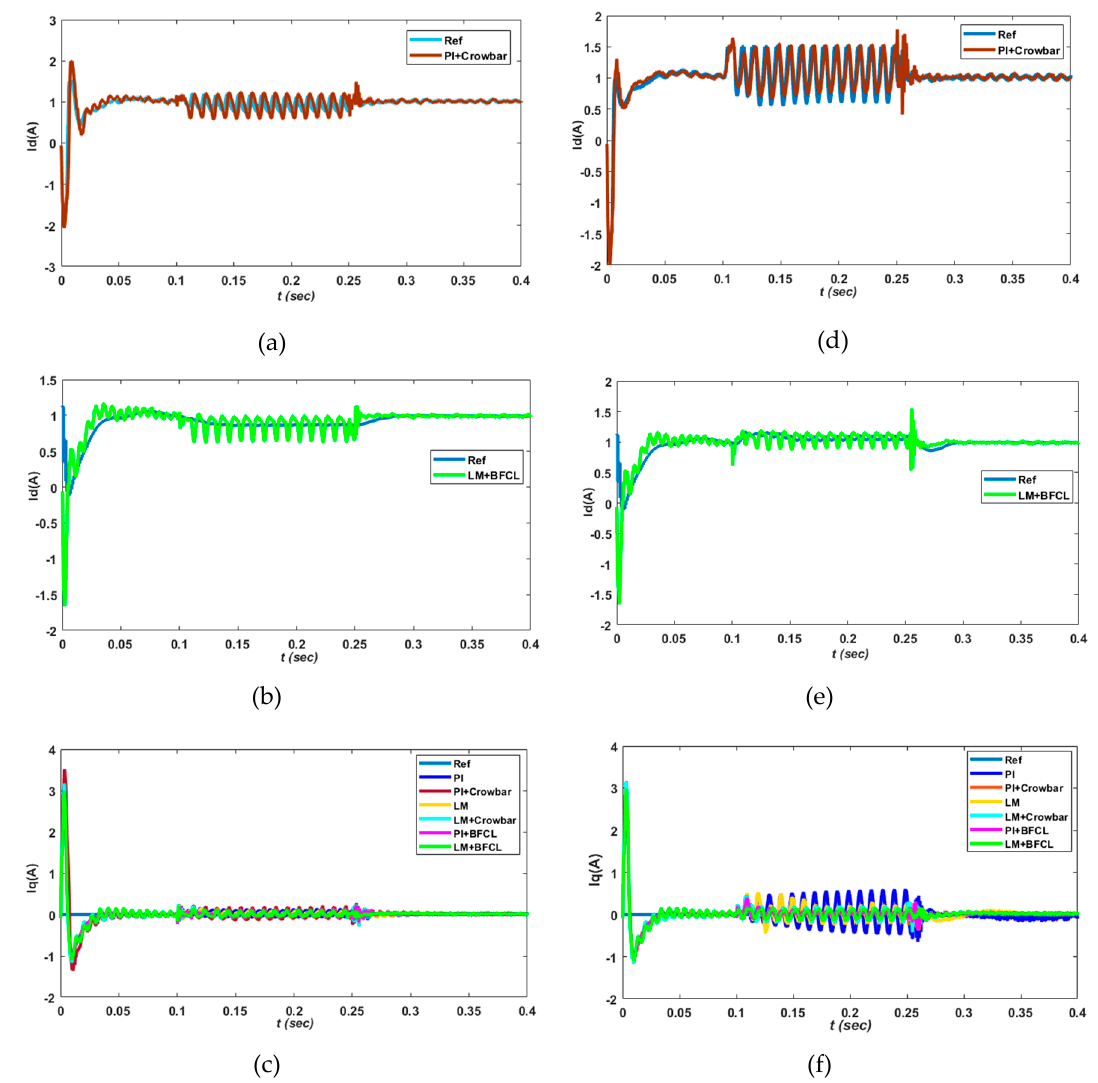
Figure 9. Active (Id), reactive (Iq) currents in 9 ( a, b, c ) and 9 ( d, e, f ) during P-G and P-P fault,